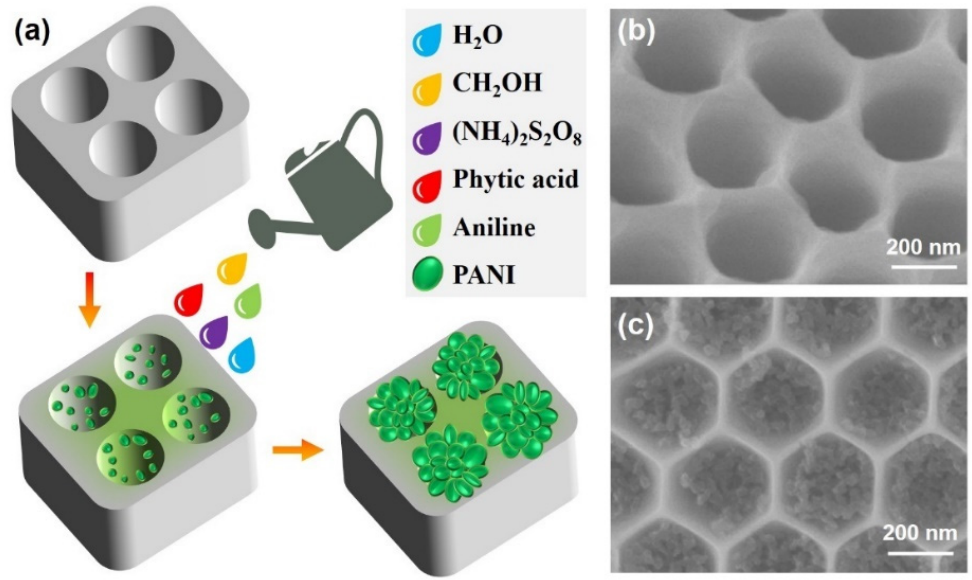
Figure 1. The preparation and structure of the solar absorber. ( a ) Schematic illustration of the preparation of photothermal materials PANI on a porous substrate. The SEM images of ( b ) AAO and ( c )